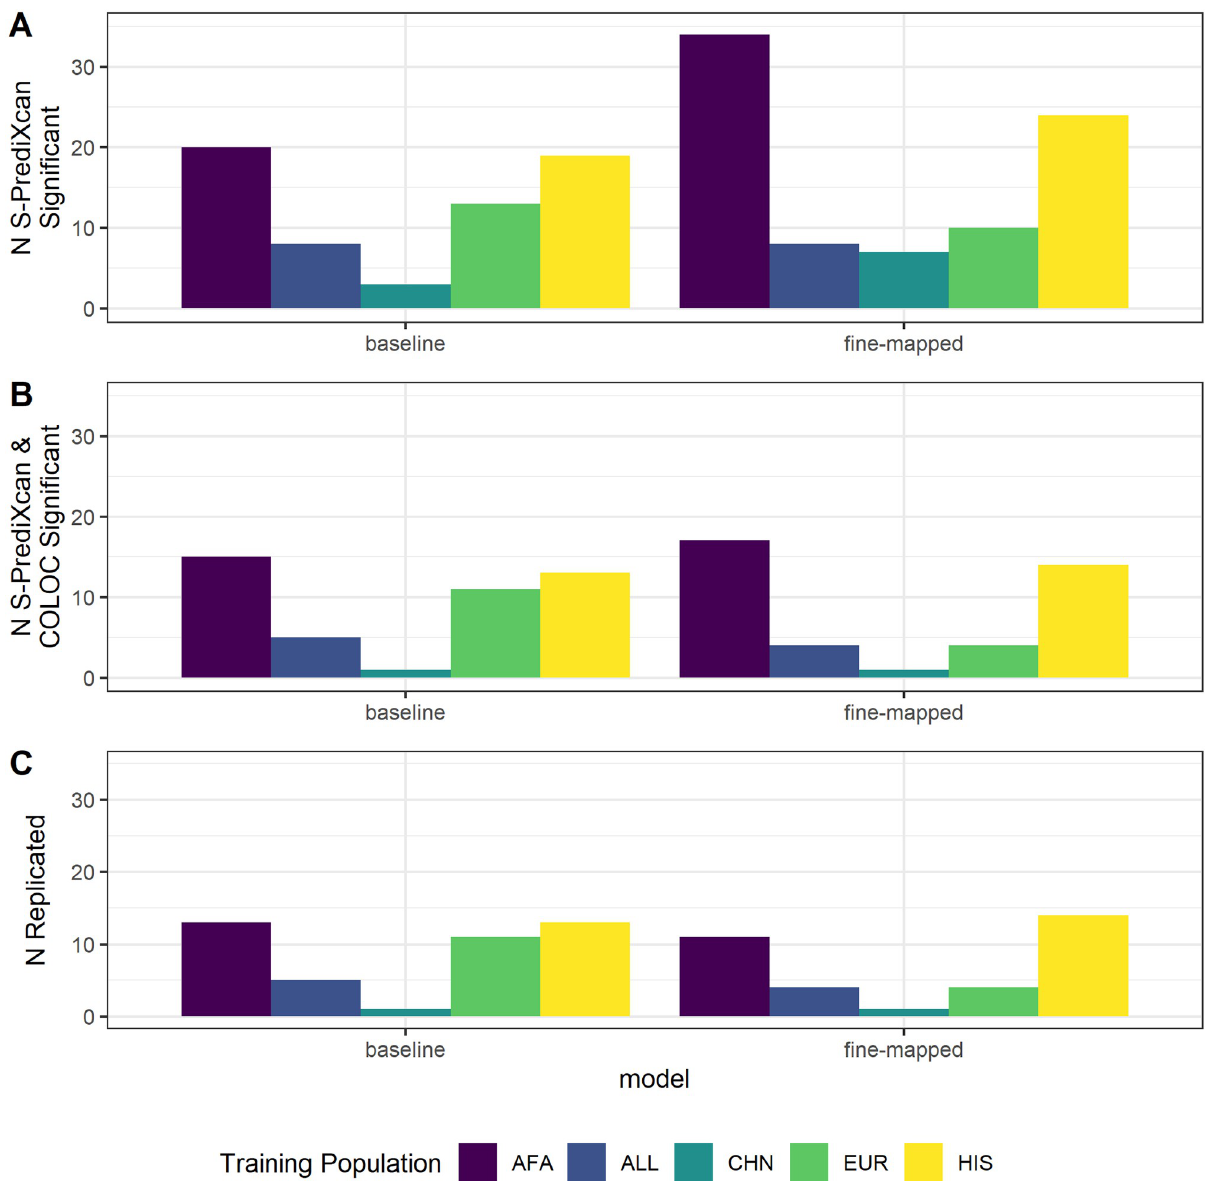
Fig 5. Predicted protein-trait association results summary. (A) Bonferroni significant (baseline p < 1.54 × 10 − 6 ; fine-mapped p < 7.60 × 10 − 7 ) protein-trait association counts when we applied S-PrediXcan to 28 traits in PAGE using protein prediction models from each TOPMed MESA population and model building strategy. (B) Protein-trait pairs from A that also have a COLOC colocalization probability > 0.5. (C) Protein-trait pairs from B that replicate (baseline p < 1.54 × 10 − 6 ; fine-mapped p < 9.59 × 10 − 7 ) in independent studies from the UKBioBank or other large, European ancestries cohorts. Bonferroni threshold for fine-mapped models is calculated separately from the Bonferroni threshold for baseline models.